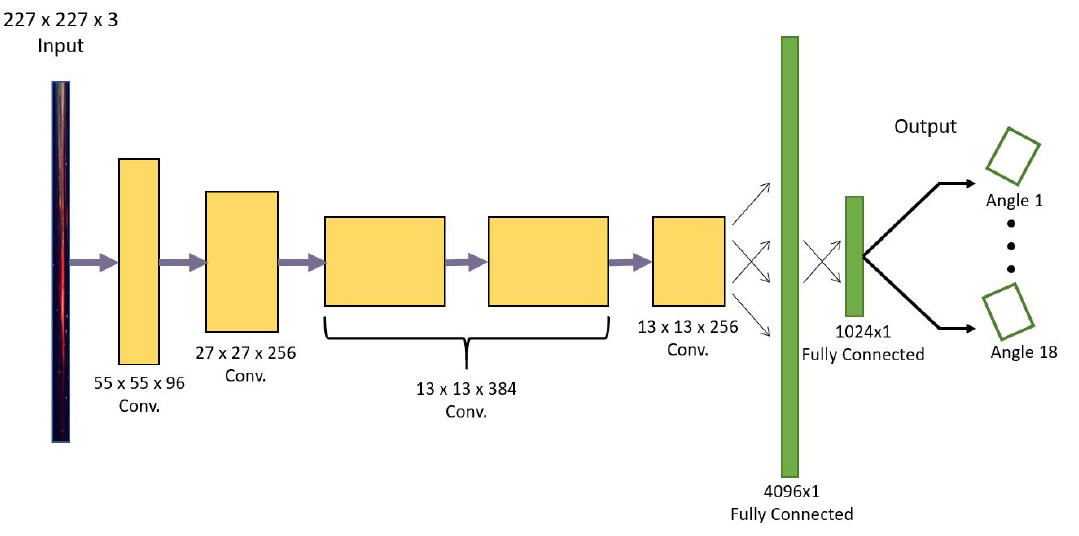
Figure 9. Eighteen-way binary classifier by Pinto et al.